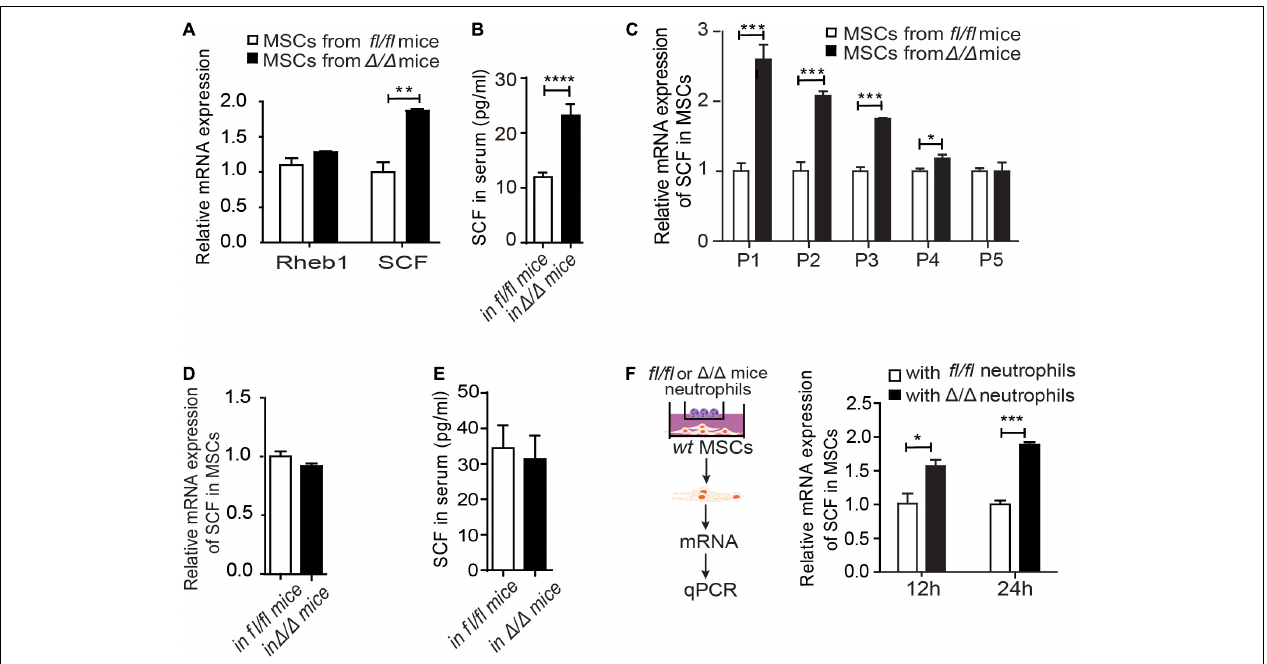
FIGURE 3 | Rheb1 -deficient neutrophils stimulate MSCs to secrete more SCF. (A) The relative mRNA expression of Rheb1 and SCF in primary MSCs from Rheb1 fl / fl and Rheb1 (cid:49)/(cid:49) mice ( n = 3). (B) The serum levels of SCF in Rheb1 fl / fl and Rheb1 (cid:49)/(cid:49) mice ( n = 4). (C) The relative mRNA expression of SCF in passage 1 (P1) to P5 cultured MSCs from Rheb1 fl / fl and Rheb1 (cid:49)/(cid:49) mice ( n = 3). (D) The relative mRNA expression of SCF in MSCs from Rheb1 fl / fl and Rheb1 (cid:49)/(cid:49) mice 4 months after wt BMC transplantation ( n = 3). (E) The serum level of SCF in Rheb1 fl / fl or Rheb1 (cid:49)/(cid:49) mice 4 months after wt BMC transplantation ( n = 3). (F) The relative mRNA expression of SCF in wt MSCs cocultured with Rheb1 fl / fl or Rheb1 (cid:49)/(cid:49) neutrophils after 12 h and 24 h ( n = 3). The data are presented as the mean ± SD. * P < 0 . 05; ** P < 0 . 01; *** P < 0 . 001; **** P < 0 .